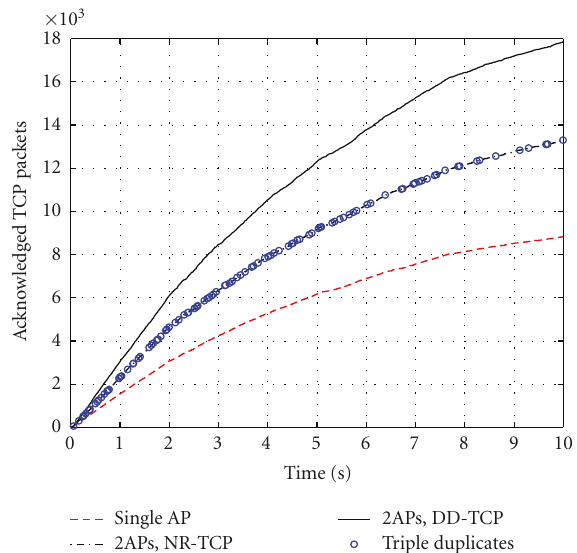
Figure 1: Acknowledged TCP packets of the download performed by one user that moves away from 2 colocated WLAN APs versus time; single RAT connection compared to parallel transmission over two RATs adopting either New Reno or delayed duplicates New Reno as TCP protocols. Triple duplicate events are marked with “o.”